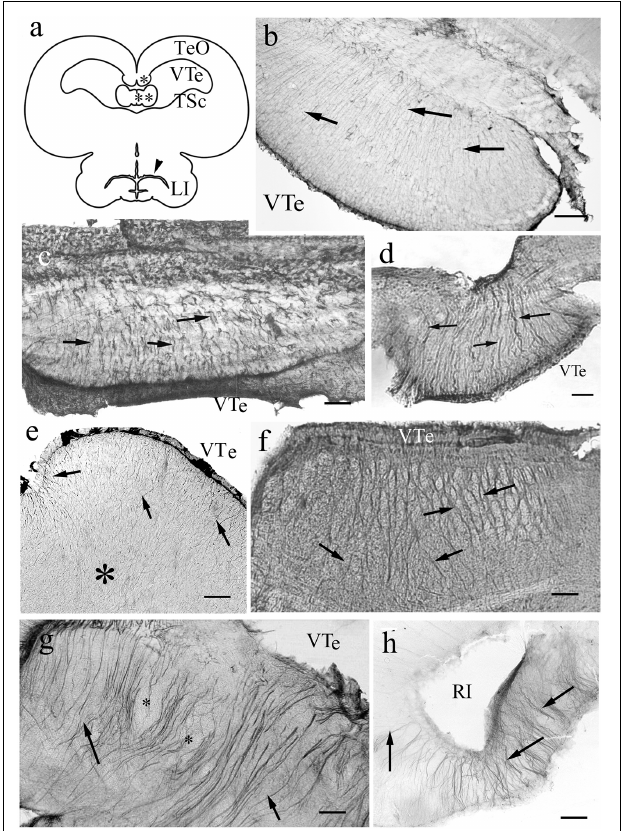
FIGURE 7 | Mesencephalon. (a) Sketch of sunfish mesencephalon, redrawn after Parent et al. (1978). LI: lobus inferior; TSc: torus semicircularis; TeO: optic tectum; VTe: tectal ventricle; asterisk: torus longitudinalis; double asterisk: valvula cerebelli, arrowhead: inferior recess of the ventricle. (b) Torus longitudinalis, knifefish, VTe: tectal ventricle, arrows: segments of radial processes. Scale bar: 120 µ m. (c) Torus longitudinalis, carp, VTe: tectal ventricle, arrows: glial processes. Scale bar: 80 µ m. (d) Torus longitudinalis, catfish, VTe: tectal ventricle, arrows: glial processes. Scale bar: 80 µ m. (e) Torus semicircularis, bichir. Fine and dense radial processes (arrows), their course is hardly followed inside the tissue (asterisk). VTe: tectal ventricle. Scale bar: 120 µ m. (f) Torus semicircularis, gar. Light spots (myelinated axon bundles) between radial glial processes (arrows). VTe: surface facing the tectal ventricle. Scale bar: 120 µ m. (g) Torus semicircularis, eel. Its inner part is rather poor of immunostaining. The neural tracts are surrounded by glial processes. VTe: tectal ventricle, arrows: glial processes, asterisks: lighter spots, myelinated axon bundles. Scale bar: 80 µ m. (h) Sander, lobus inferior, RI: the recessus inferior of the mesencephalic ventricle, note the radial processes around (arrows). Scale bar: 80 µ